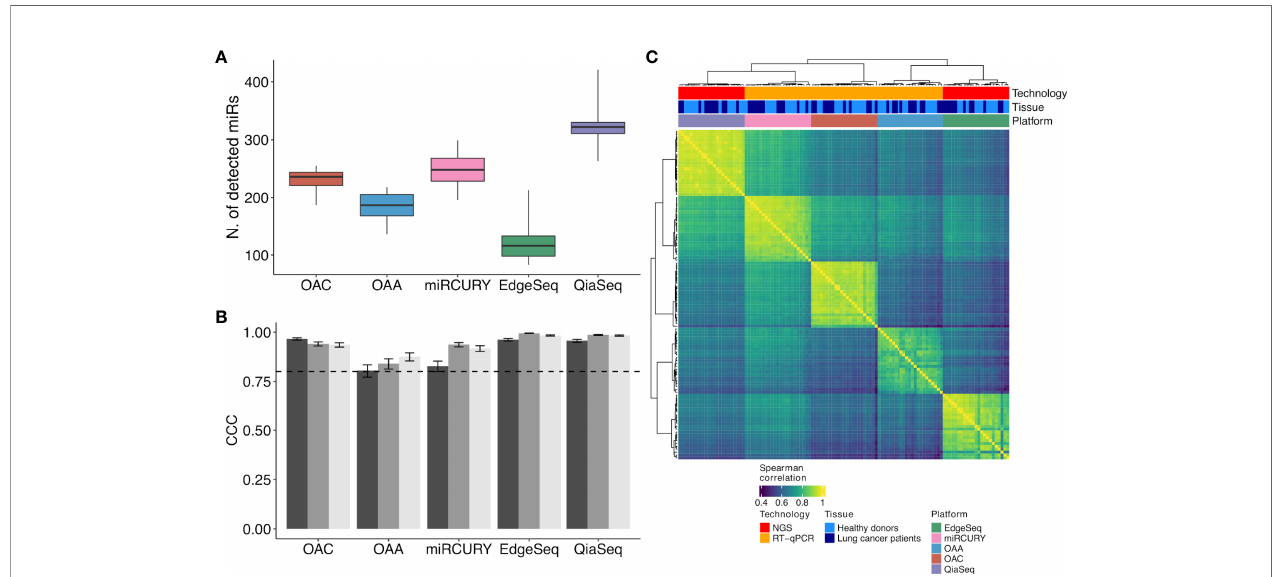
FIGURE 2 | ct-miR detection and correlation and concordance analysis across duplicates and platforms. (A) Boxplots representing the number of detected ct-miRs in each platform, calculated after normalization and fi ltering, with respect to the 488 common miRs. (B) Grouped bar plots showing the concordance and correlation coef fi cient calculated among the three duplicates in each platform for the 488 common miRs. The vertical bars indicate the 95% con fi dence interval of the correlation. The horizontal dotted line represents the threshold of the minimum correlation value, 0.8. The black, gray, and light gray bars refer to technical duplicates from three plasma samples. (C) Correlation heat map showing the agreement between the fi ve platforms. Spearman correlation was calculated on the samples ’ z- scores of each platform considering the 488 miRs common to all platforms. Hierarchical clustering was performed using Euclidean distance and Ward